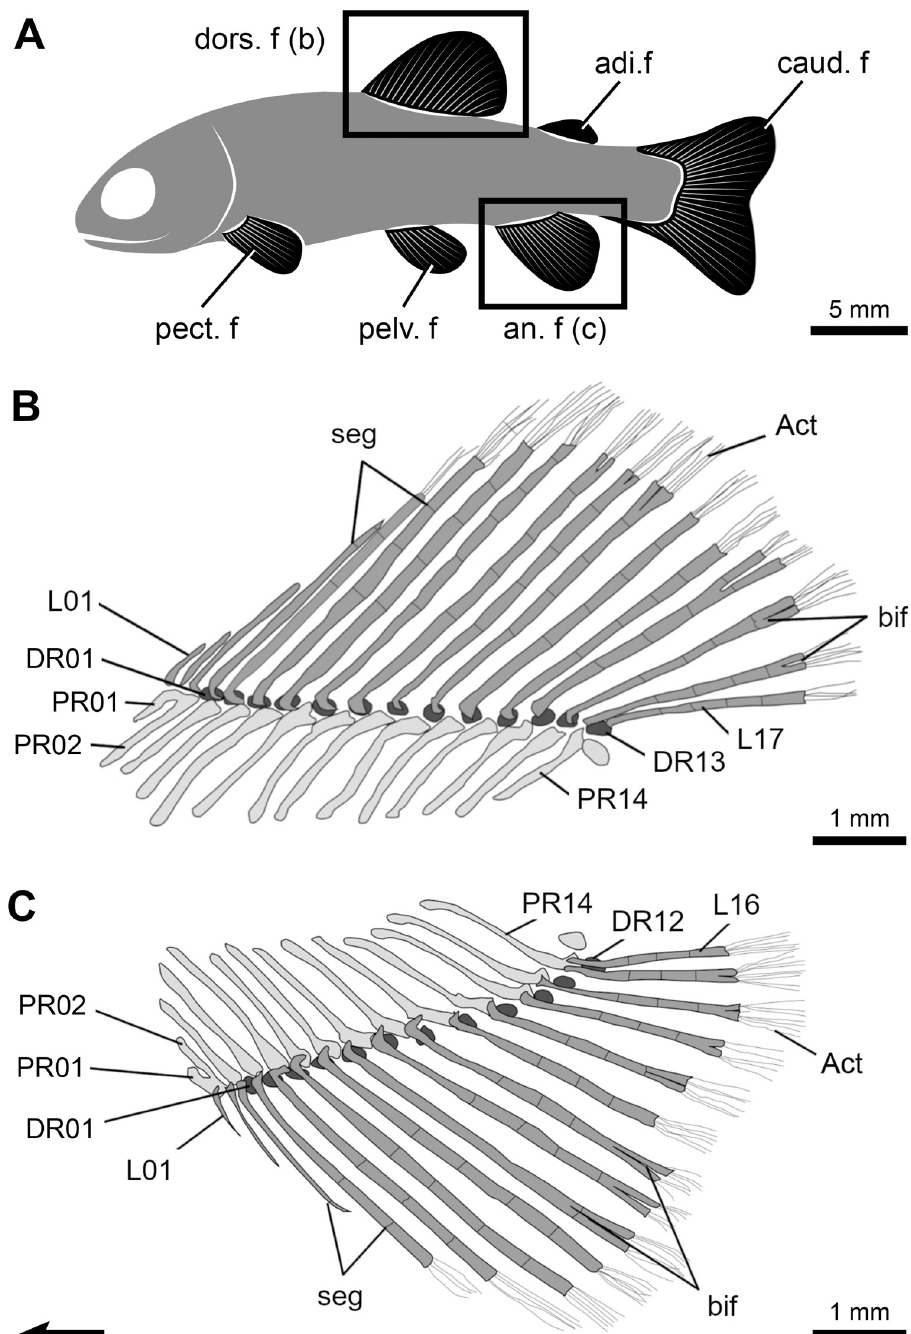
Fig 1. Fin structure and anatomy of the rainbow trout ( Oncorhynchus mykiss ) based on a 31.33 mm long juvenile specimen. A, General disposition of the paired and median fins (detailed insets). B, C, Details of the dorsal ( B ) and anal ( C ) fins. The main morphological features of these fins are identified. The serial elements, the proximal radials (PR), the distal radials (DR) and the lepidotrichia (L), are numbered from the anterior to the posterior of the fins. Arrow points anteriorly. Act, actinotrichia; adi.f, adipose fin; an.f, anal fin; bif, bifurcation; caud.f, caudal fin; DR, distal radial; dors.f, dorsal fin; L, lepidotrichia; PR, proximal radial; pect.f, pectoral fin; pelv.f, pelvic fin; seg, segmentation.